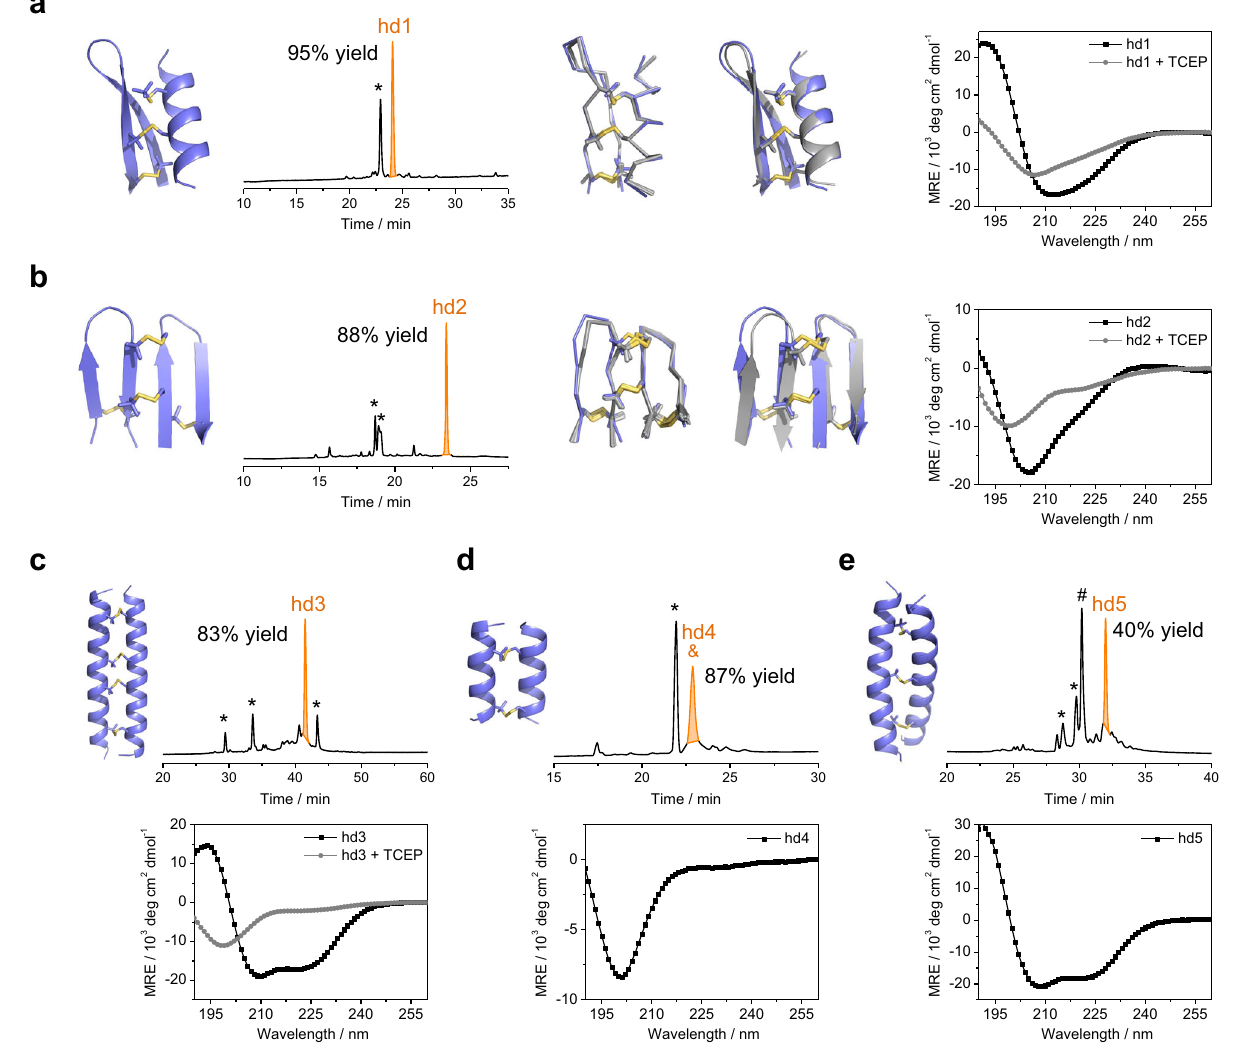
Fig. 3 Synthesis and characterizations of the designed peptide heterodimers. a – e Cartoon representations of design models; C α traces of NMR ensembles (gray) and cartoon representation of the lowest energy conformer of each NMR ensemble (gray) aligned to the design model (blue slate); HPLC chromatograms showing the dimeric folding of these designed heterodimers (concentration of Cys- and Pen-bearing monomers: 100 and 200 μ M respectively; * denotes the oxidized Pen-bearing monomers of hd1 ‒ hd5, which are excess relative to the Cys-bearing monomers in the folding buffers); & a peak containing both the correctly-paired antiparallel heterodimer (hd4) and the undesired parallel heterodimer; # denotes the undesired antiparallel heterodimer. CD spectra of the heterodimers were recorded in water at room temperature. TCEP was added to record CD spectra of the reduced monomers (hd1 – hd3). Source data are provided as a Source Data fi